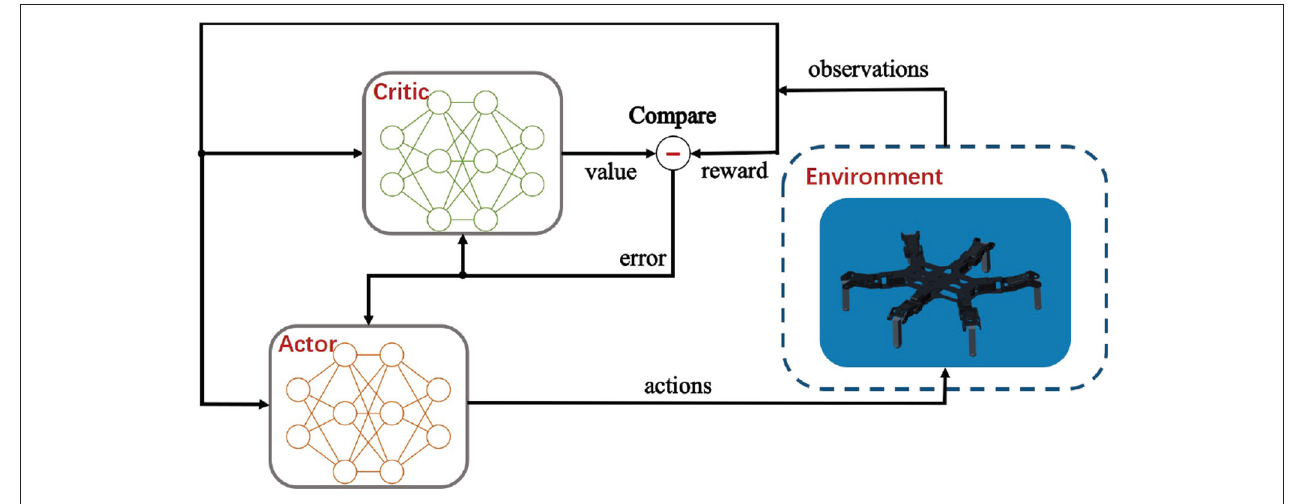
FIGURE 6 | The DDPG-based reinforcement learning